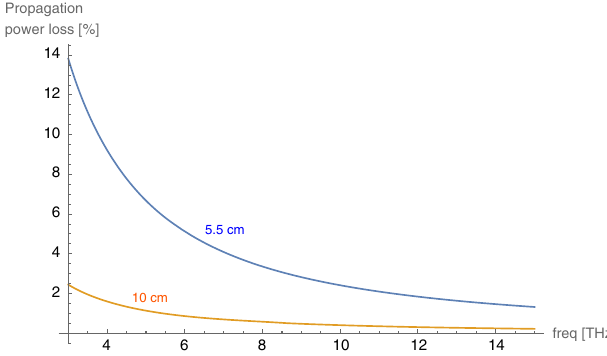
FIG. 3. Power loss for 150 m (to reach the near experimental hall at LCLS) for the frequency range 3 – 15 THz, using an iris line with a period of b ¼ 30 cm and two iris radii ( a ¼ 5 . 5 or 10 cm). This prediction is based on the Vainstein model and assumes zero screen thickness. The larger radius is recommended for lower loss, if mechanically feasible.